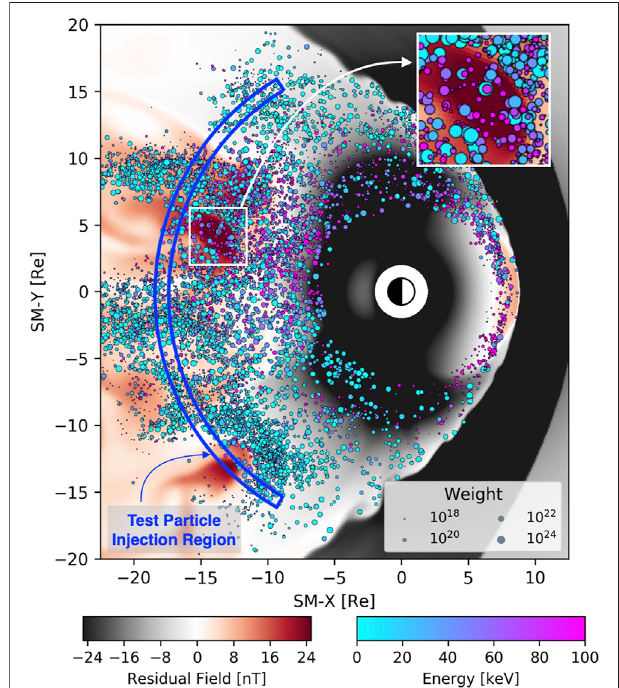
FIGURE 1 | Simulation at a glance. Combined visualization of the MHD simulation and test particle data. Background color (bottom let color bar) denotes residual, i.e., non-dipolar, vertical magnetic fi eld. Test particles are markedatthelocationoftheir fi eld-lineprojectiontotheequatorialplane, colored by their energy (bottom right color bar), and denoted with a marker whose surface area is proportional to the logarithm of their weight. The region where test particles are seeded is marked in blue. Figure inset shows a close- up view of the test particle population in a typical